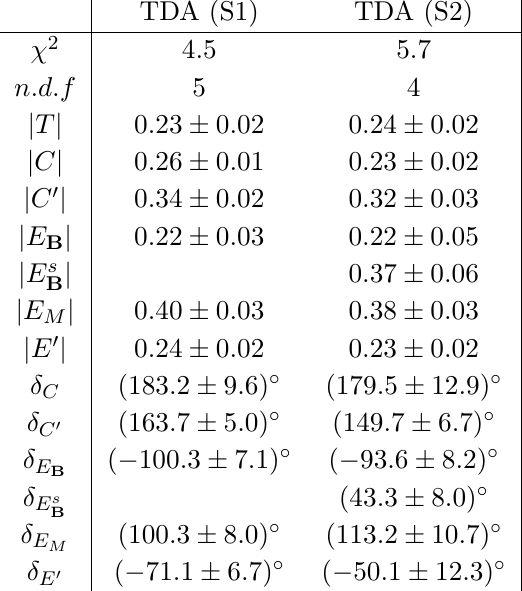
Table 4 . Fit results of the topological parameters in S1 and S2 for the exact and broken SU(3) f symmetries, respectively. Besides, ( | T | , | C ( 0 ) | , | E ( s ) number of degrees of